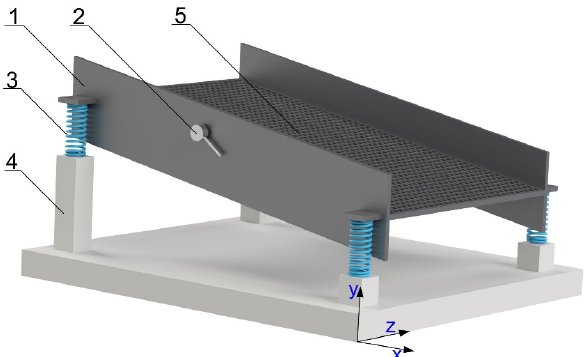
Figure 1. Physical model of the vibrating screen with circular vibrations used in the analysis: 1—vibrating mass; 2—inertial vibrator; 3—elastic elements supporting the screen; 4—supporting structure; 5—screen surface.